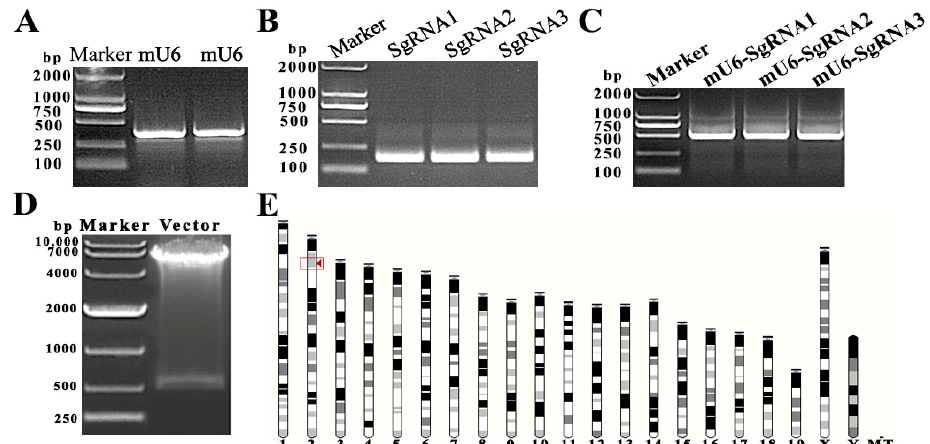
Figure 1. Construction of lentiviral shuttle vector pLV-mU6-Tubb4b-SgRNA-EGFP. ( A ): amplification of mU6 fragment (375 bp); ( B ): Tubb4b target sequence and the amplification of SgRNA fragment (163 bp); ( C ): mU6-Tubb4b-SgRNA sequence (518 bp) amplification; ( D ): plvx-mU6-Tubb4b-SgRNA-blast-EGFP lentiviral shuttle vector double enzyme digestion ( Nhe I and Xho I) verification; ( E ): Tubb4b-sgRNA target sequence in the chromosomal position of the mouse